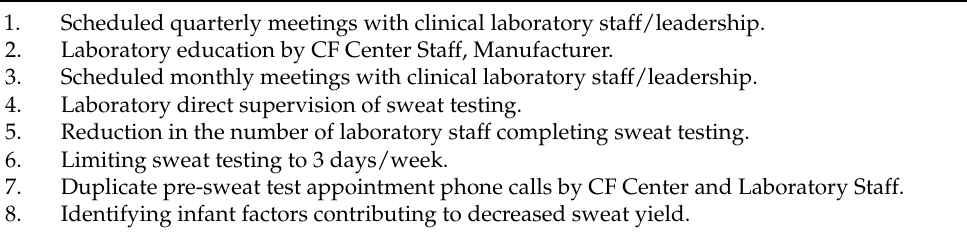
Table 1. Quality Improvement Initiatives to Improve Sweat Testing Quantity Not Sufficient